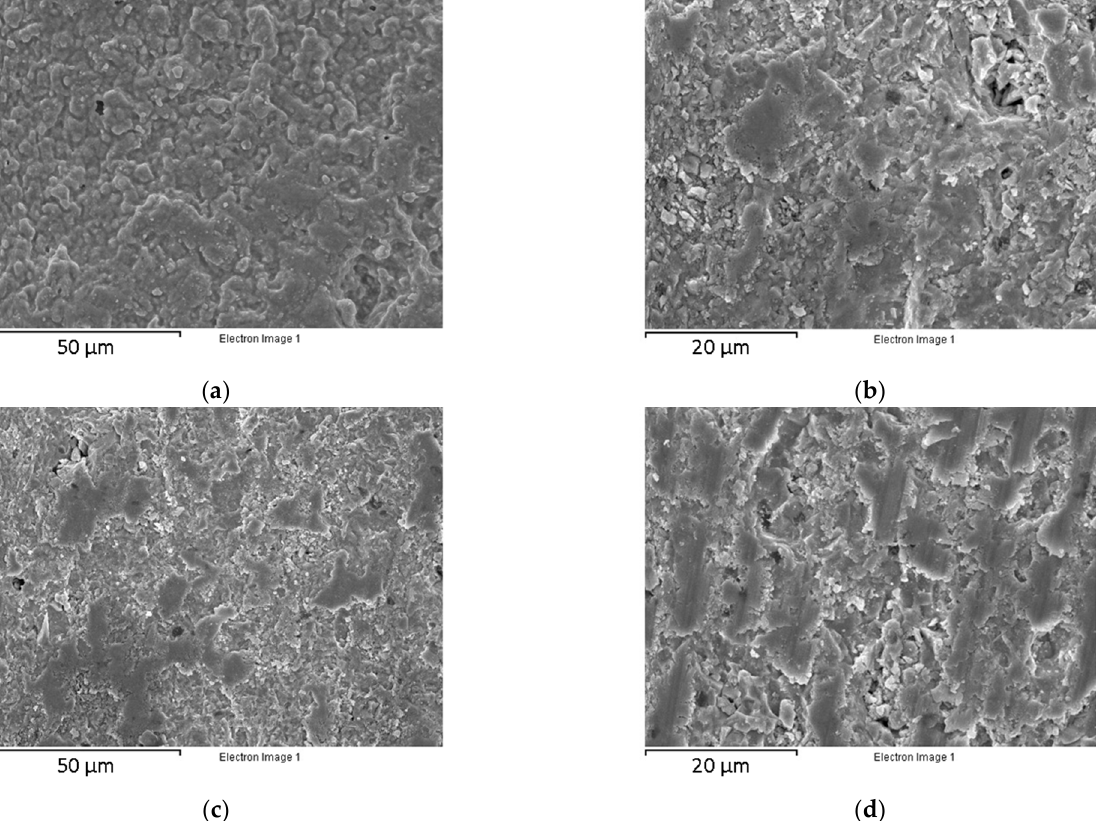
Figure 5. Micrographs of the BCZY 3D-printed pieces after sintering: ( a ) BCZY-Pellet surface, ( b ) BCZY-Pellet cross-section, ( c ) BCZY-Crucible surface and ( d ) BCZY-Crucible cross-section.